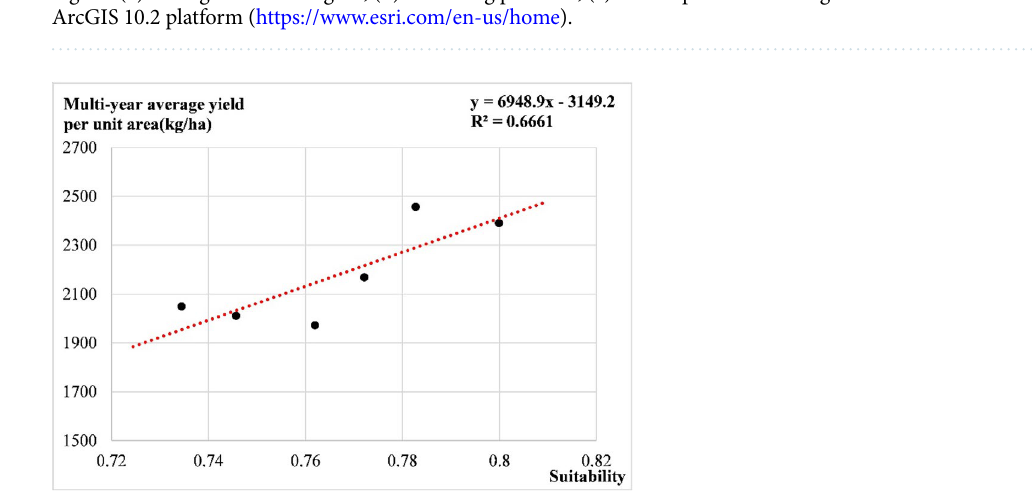
Figure 14. Spatial distribution map of multi-year average yield reduction rate of peanut in Huang-Huai-Hai region: ( a ) Huang-Huai-Hai region; ( b ) Shandong province; ( c ) Henan province. The figure was made in the ArcGIS 10.2 platform (https:// www. esri. com/ en- us/ home).